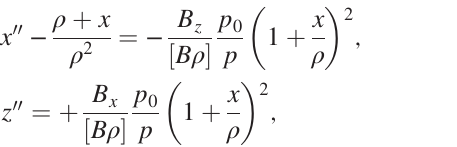
TABLE I. Parameters of the injection system. Parameters